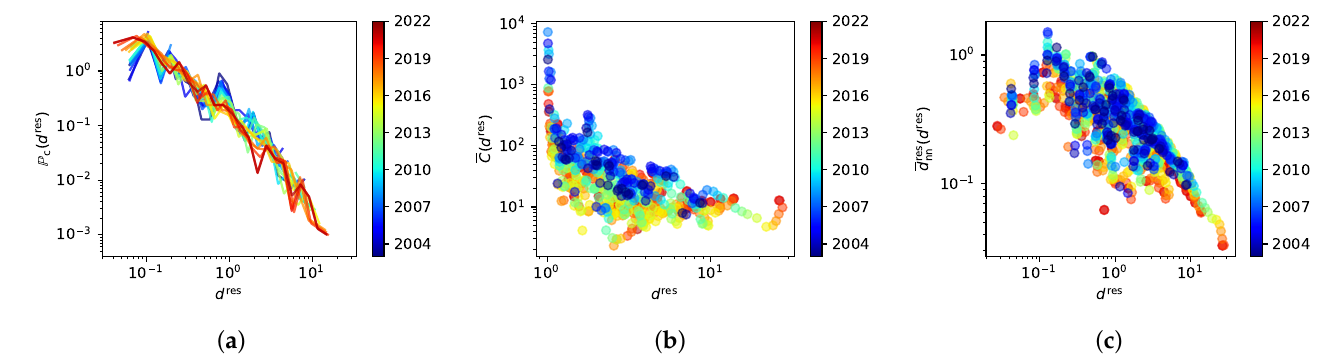
res ( d res ) . Each color nn